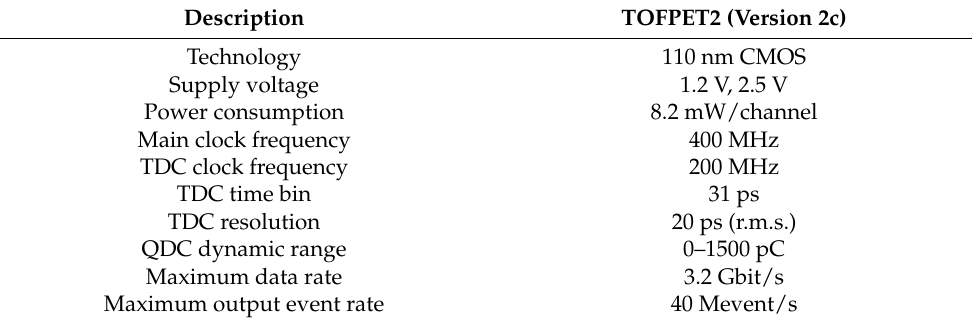
Table 1. Brief specifications of the